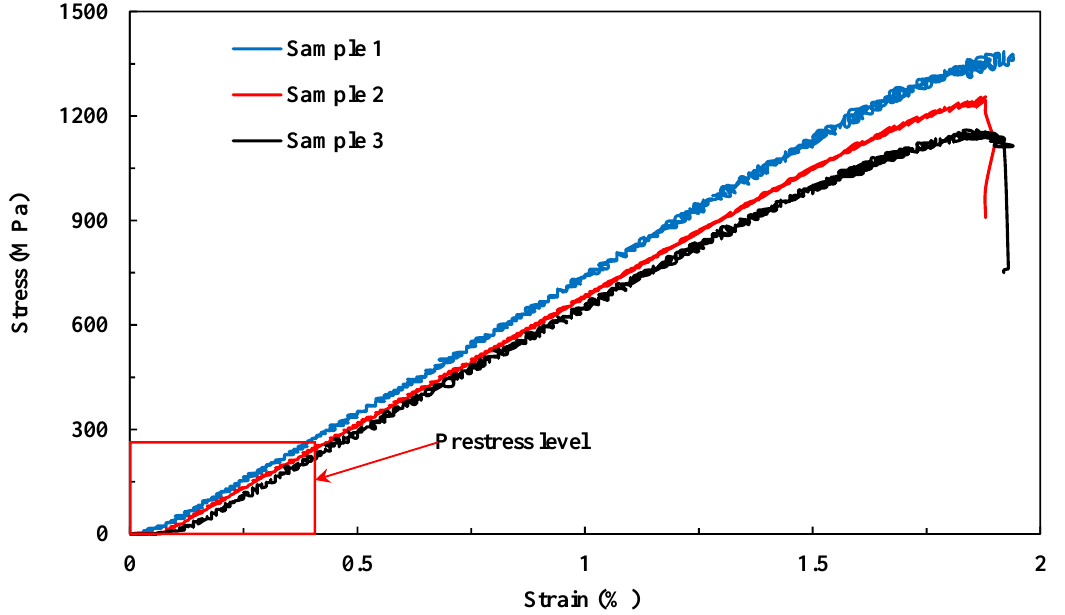
was controlled within 230 MPa, as highlighted in Figure 4, it corresponds to an elastic strain level within 0.4%. Figure 4. Stress – strain curves of prestressed unidirectional carbon fibre composite. Figure 3. Stress–strain curves of prestressed unidirectional carbon fibre composite.